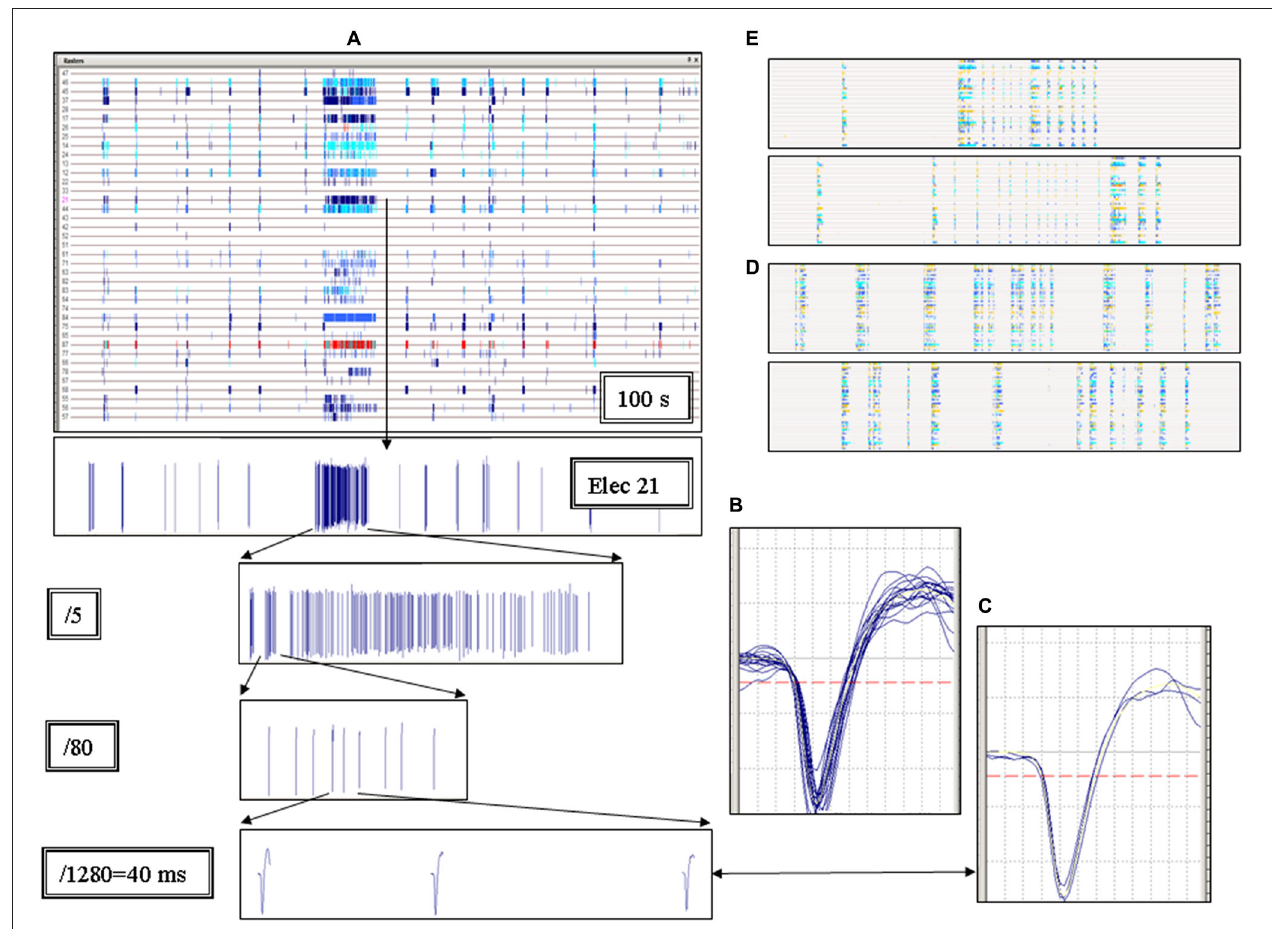
21 are shown in the 1st, 2nd, 3rd and 4th bottom inset, at increasing time scale magnifications, as indicated. The last inset on the bottom shows 40 ms continuous recording. (B–C) Plots of the spike waveforms on a time-scale of 1.2 ms. The spikes shown in the 4th inset are superimposed in panel B and originated from the very long up-state. The spikes of all the very short network bursts following the long one are superimposed in panel C. Notice the similarity between all of these waveforms. (D–E) Raster plots representative of other experiments in Mutant cultures (duration and timescale were as in A